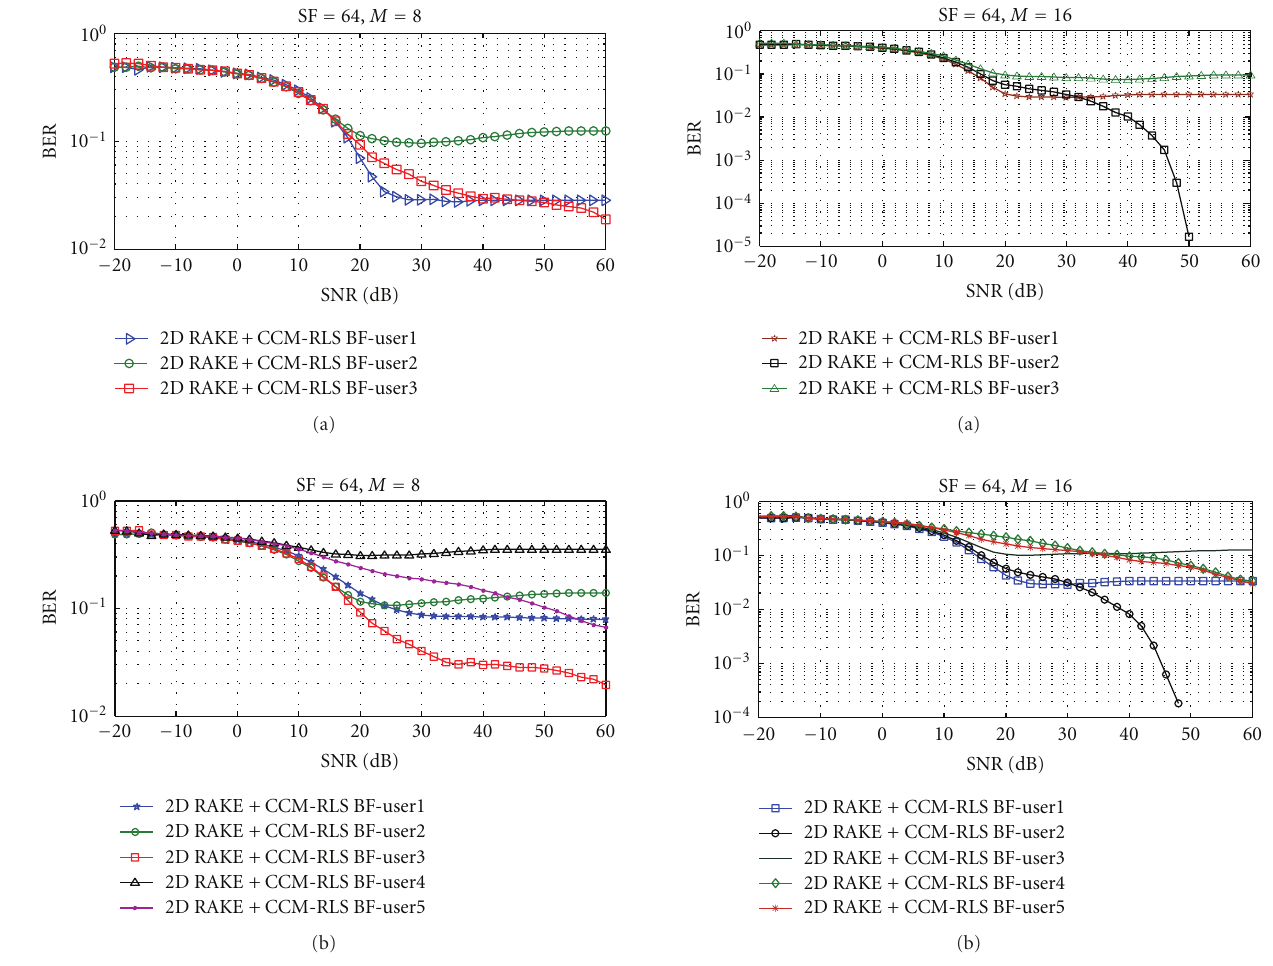
Figure 8: Performance of proposed receiver considering 8-element antenna array in 3-path AWGN fading channel for (a) 3 users, (b) 5 users.